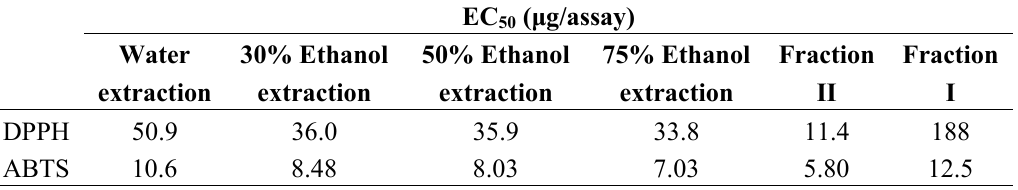
Table 3. Antiradical activities in chestnut burs extracts and